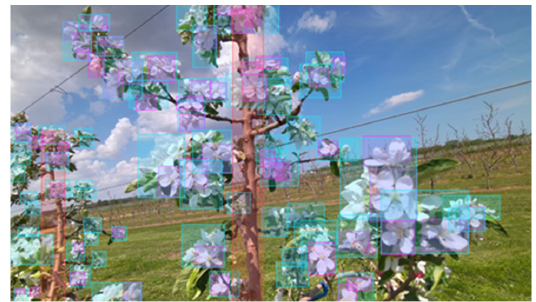
Figure 5. Training dataset in its first iteration.